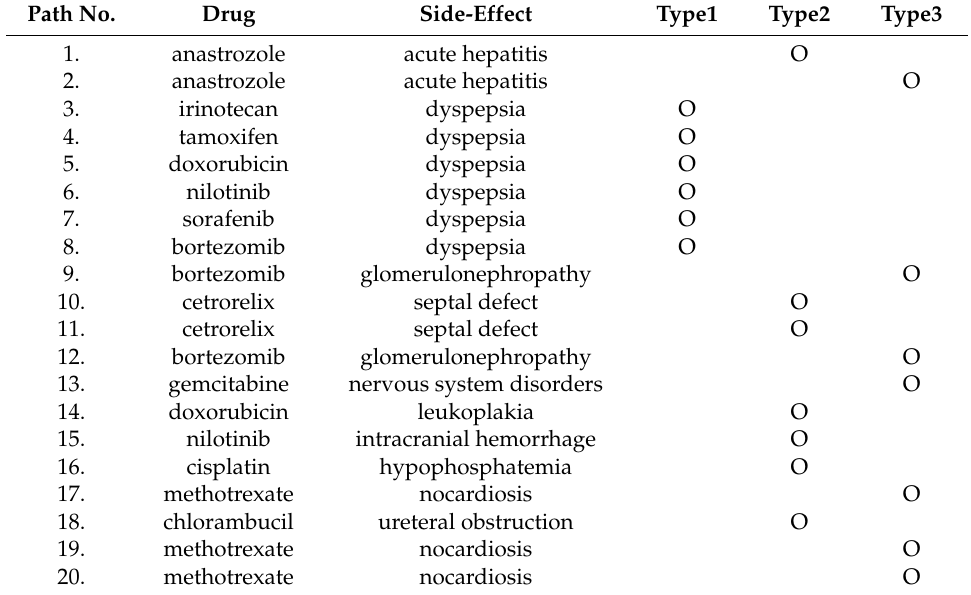
Table 5. Biological analysis result (top 20